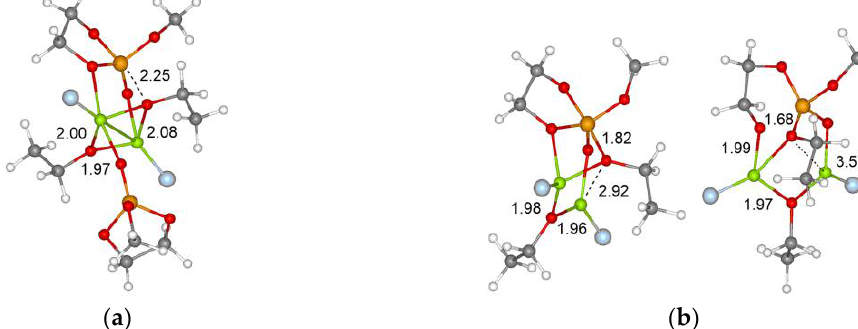
Figure 2. ( a ) Cooperative effect of di-Mg core in transition state DTS-12 ; ( b ) Geometries of the highly distorted transition state DTS-12i and intermediate DI-2i with a highly weakened exocyclic P–O bond (DBP fragments are omitted for clarity, DBP oxygen atoms are marked in blue).